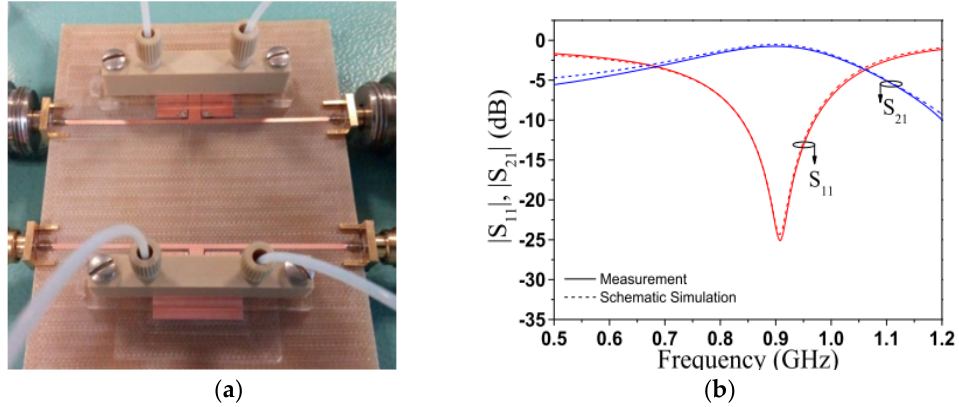
Figure 24. ( a ) Prototype sensor containing connectors and the fluidic channels; ( b ) reflection coeffi- cient of the single OCSRR loaded with DI waster [68].